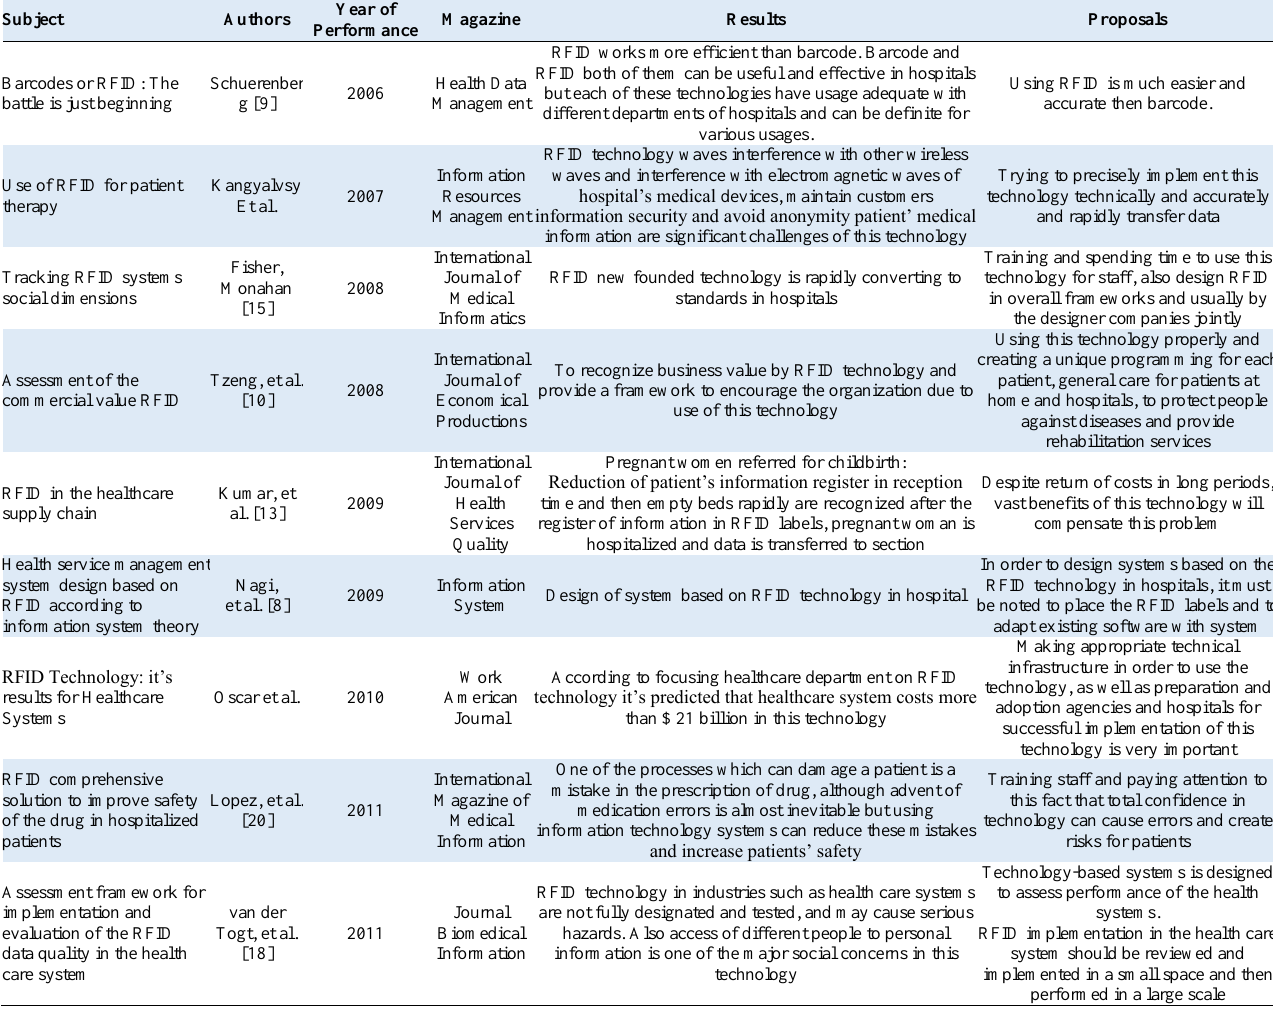
Table 1. Comparative studies conducted in the field of RFID